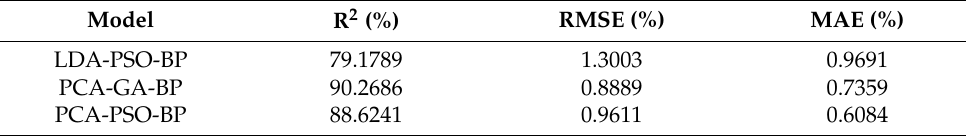
Table 5. Prediction results of the different models when the moisture content was less than 64%.